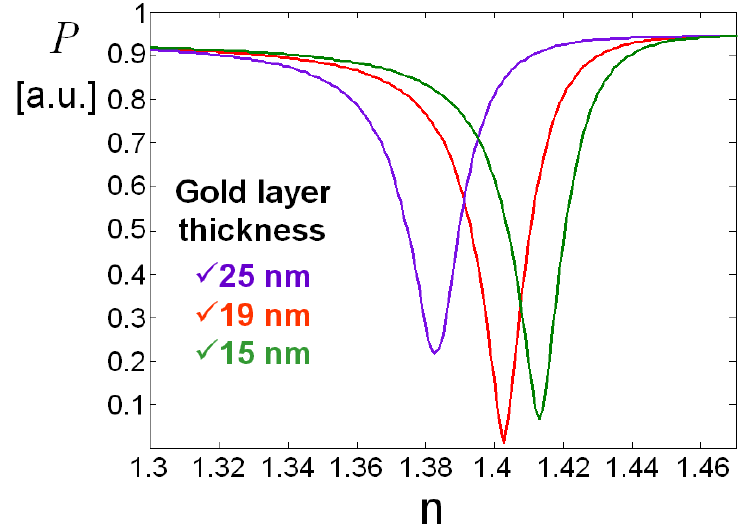
Figure 4. Resonance behavior vs. sensing window gold layer thickness (P, transmitted intensity; n, refractive